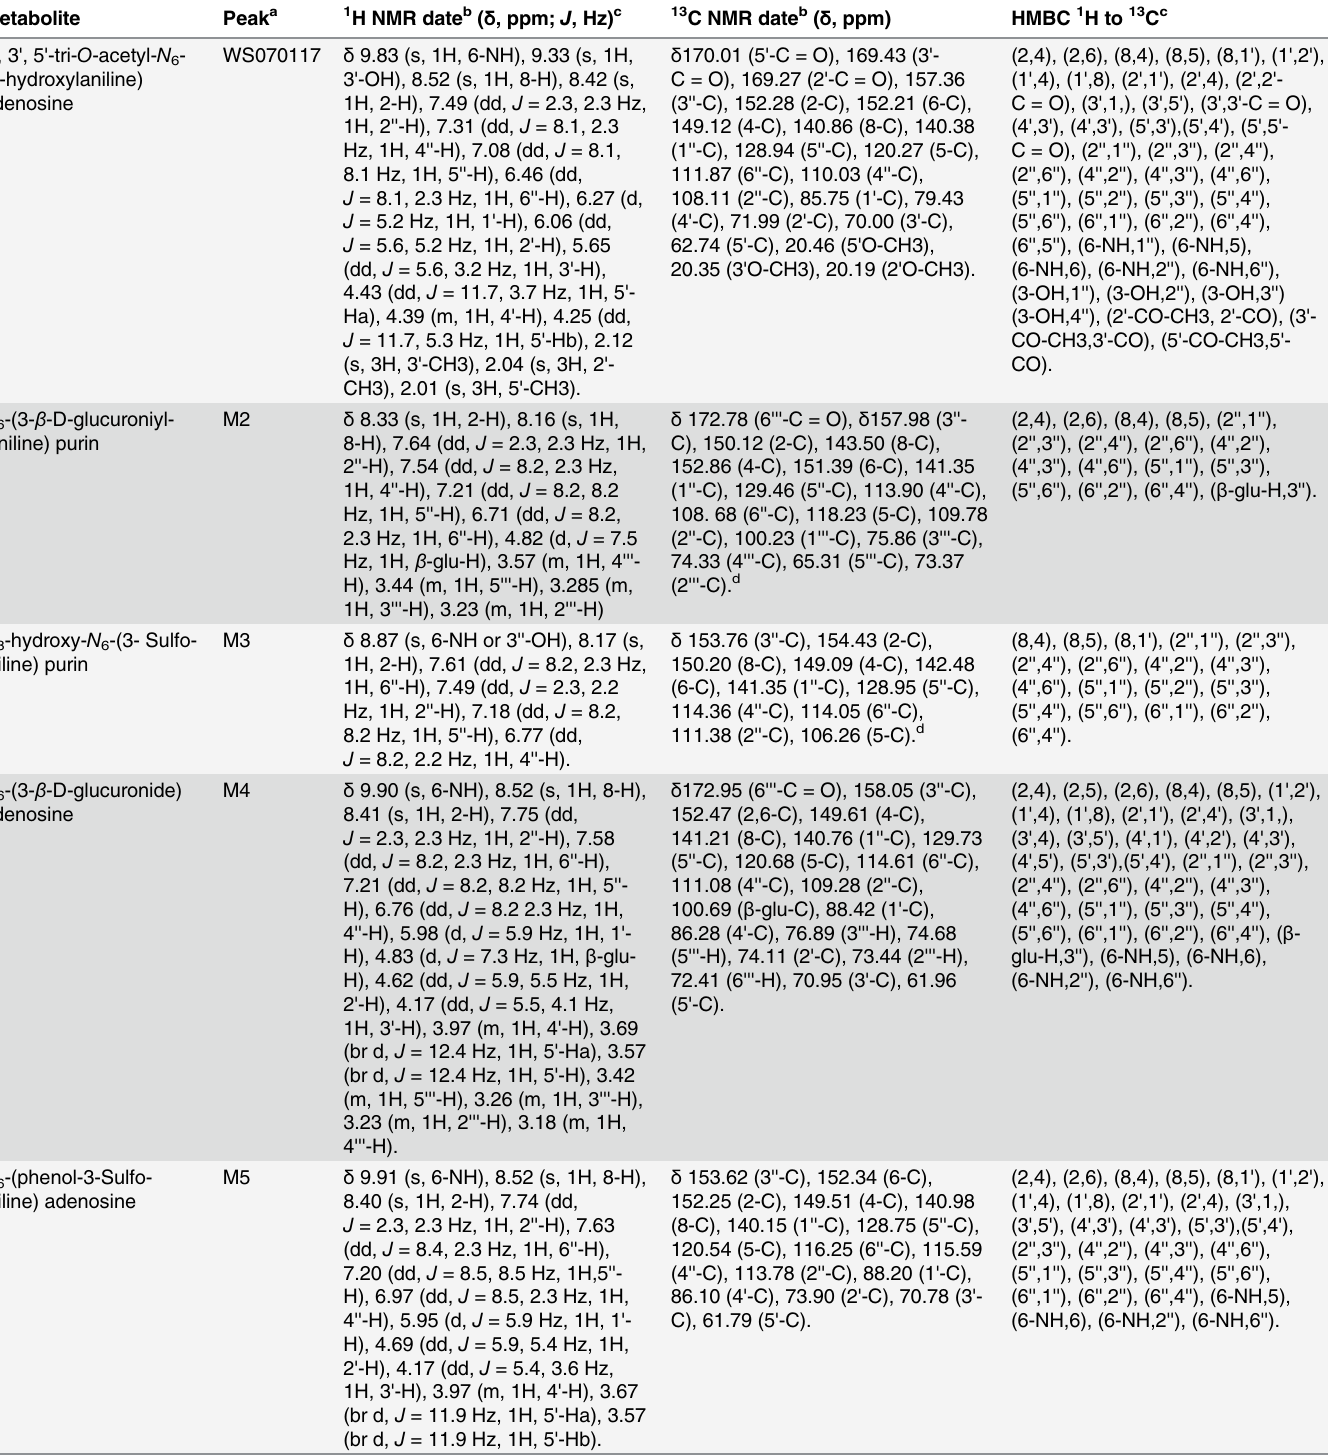
Table 2. Structure assignments of WS070117 and its metabolites with 1 H, 13C and HMBC NMR data from off-line measurements.